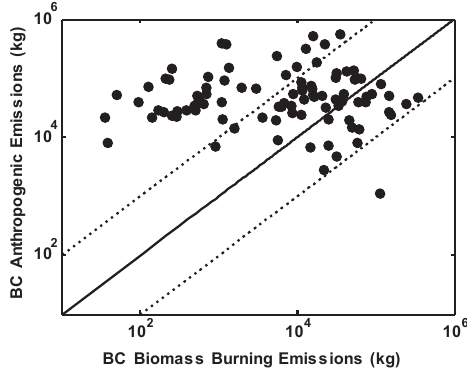
Figure 5. Monthly anthropogenic and biomass burning emissions of BC in each 2 ◦ × 2.5 ◦ grid box for August 2006 (unit: kg). Solid line is 1:1 and dashed lines are 1 : 10 (or 10 :